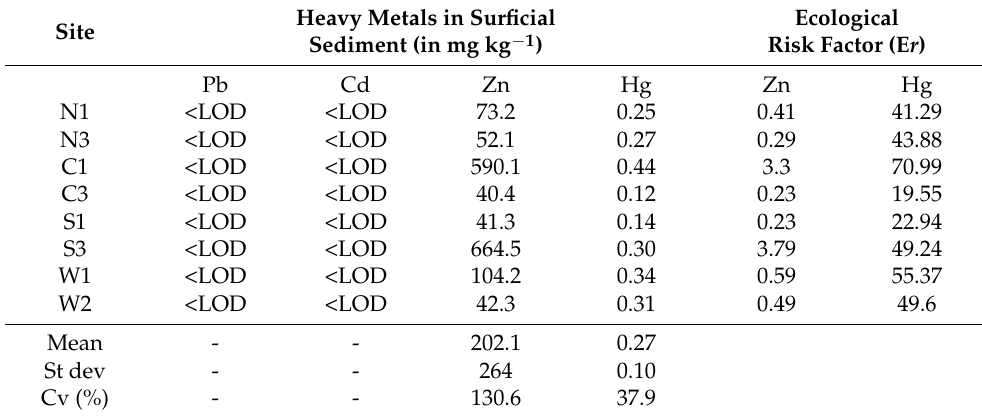
Table 1. Heavy metal concentrations and basic statistical metrics in surficial sediment in La Sabana and associated ecological risk factor.